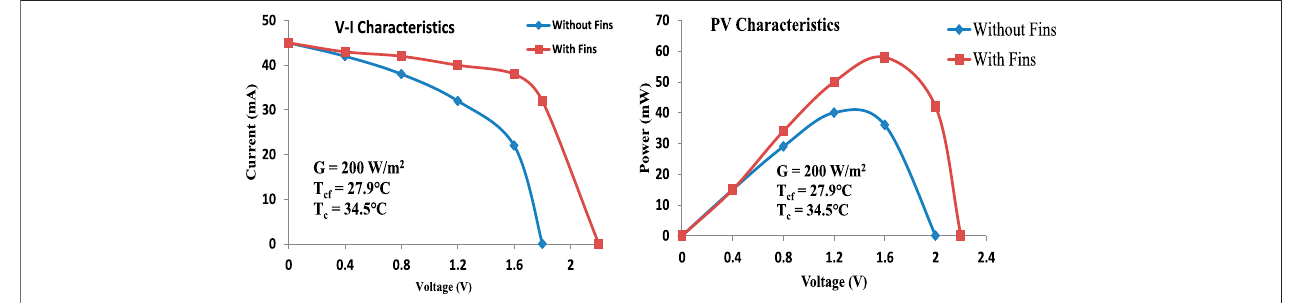
FIGURE 7 | V-I and P-V characteristics with and without fi ns.